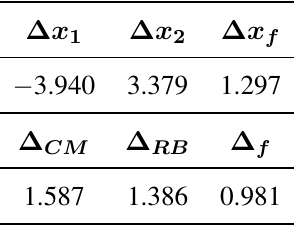
Table 4. Experimental results of the data fused by KF and MOIFA (units: